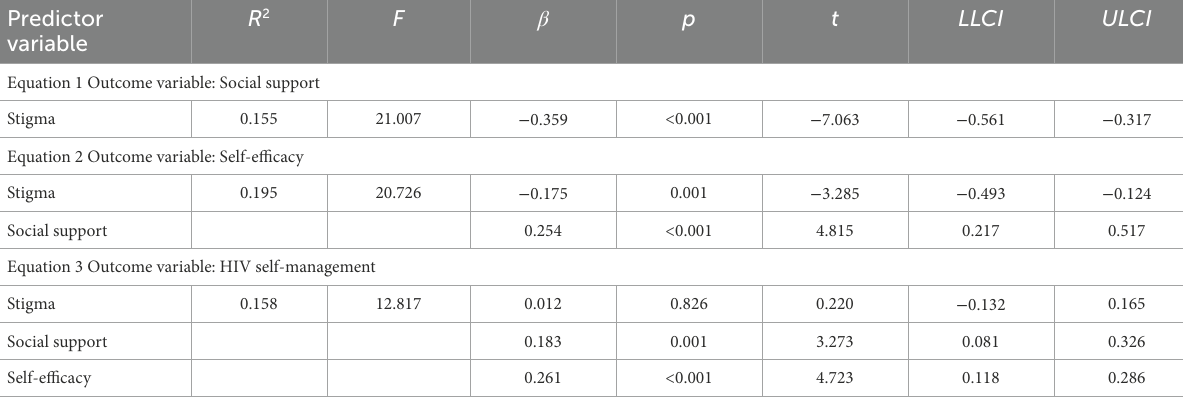
TABLE 3 Regression coefficients in the serial mediation analysis. Predictor